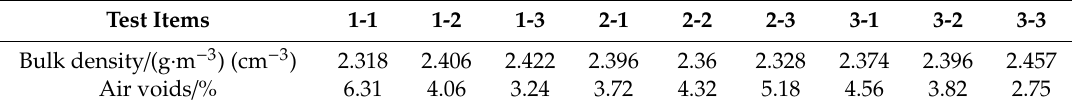
Table 11. Air voids of gyratory compaction specimens.